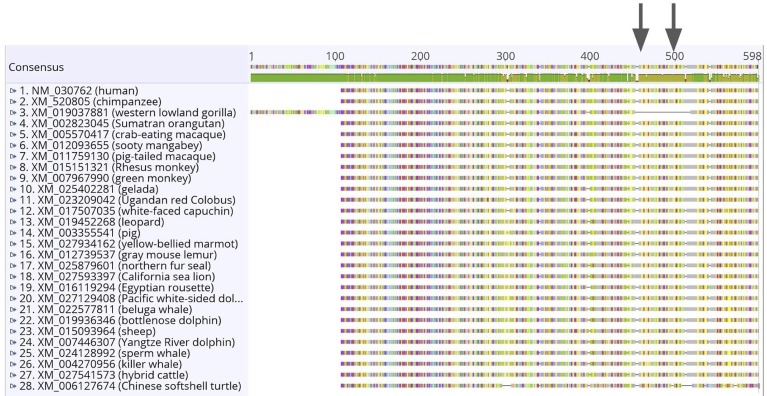
Multiple sequence alignment of the BHLHE41 mRNA for 27 mammals and one reptile outgroup.Sequence identity is shown immediately below the consensus (green = 100% identical; gold = 25–99% identical; red < 25% identical). The two amino acid variants known to affect sleep behavior in humans (P385R and Y362H) are indicated with arrows. The alignment shows two unexpected findings in the gorilla sequence: a 318 base pair insertion on the 5’ end and a 195 base pair gap starting at bp 1360.